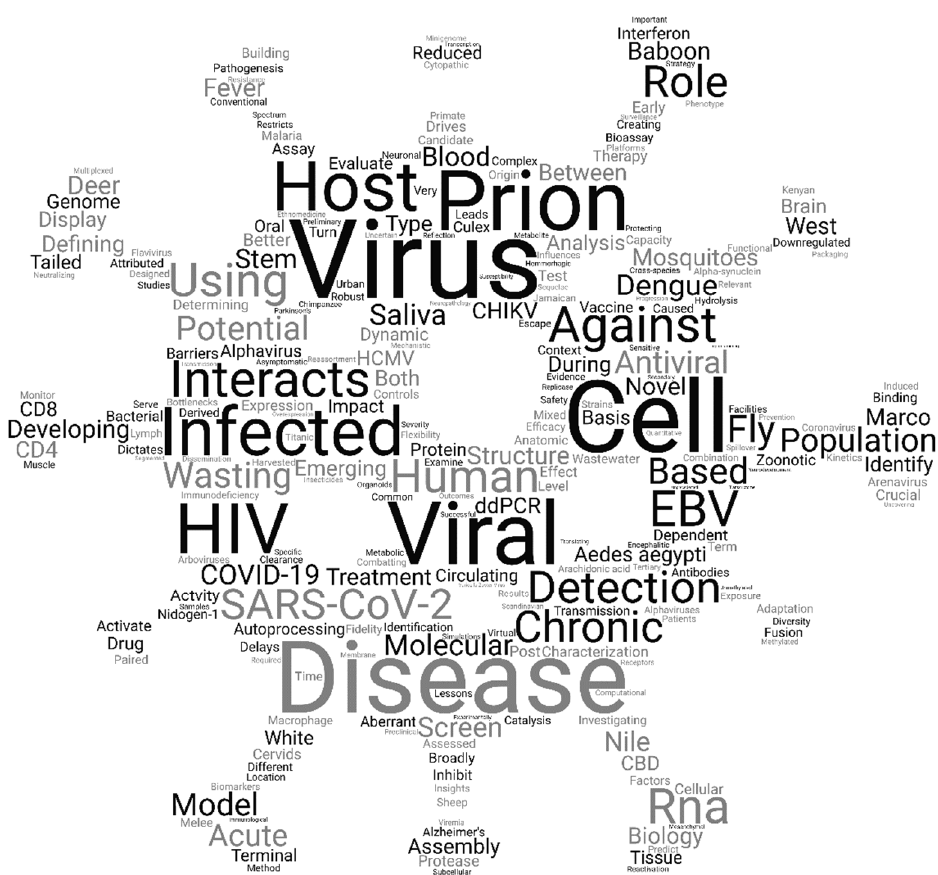
Figure 2. The Longest Coherent Sentence Word Cloud and Award. Brynn Lauterbach of Colorado State University won with her sentence of 109 words: “Surveillance of exposure, asymptomatic transmission, dissemination, activity, progression, and antiviral drug resistance of important emerging cross-species viral disease of humans, urban Aedes aegypti and Culex mosquitoes, Scandinavian sheep, white tailed deer, Jamaican baboons, Kenyan chimpanzees, cervids, and specific relevant primates in different locations impacts the detection of arbovirus, flavivirus, arenavirus, and alphaviruses and is crucial in determining the level of host spillover and developing a cellular or RNA vaccine, stem cell-derived therapy, circulating neutralizing antibodies, and creating complex and sensitive quantitative immunological bioassays, novel computational model simulations, and ddPCR in experimentally assessing and characterizing expression of cellular factors, biomarkers, and susceptibility of samples against a spectrum of combination treatments.” The word cloud was generated using the WordArt.com word cloud generator, and image licensing was provided to Laura A. St. Clair.